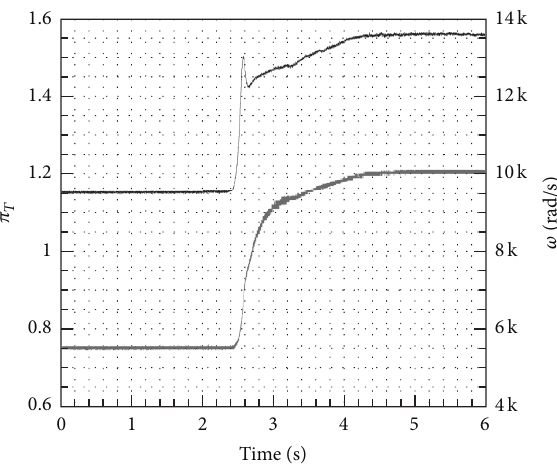
Figure 4: Time evolution of the pressure ratio in the stage (upper curve) and of the rotational speed (lower